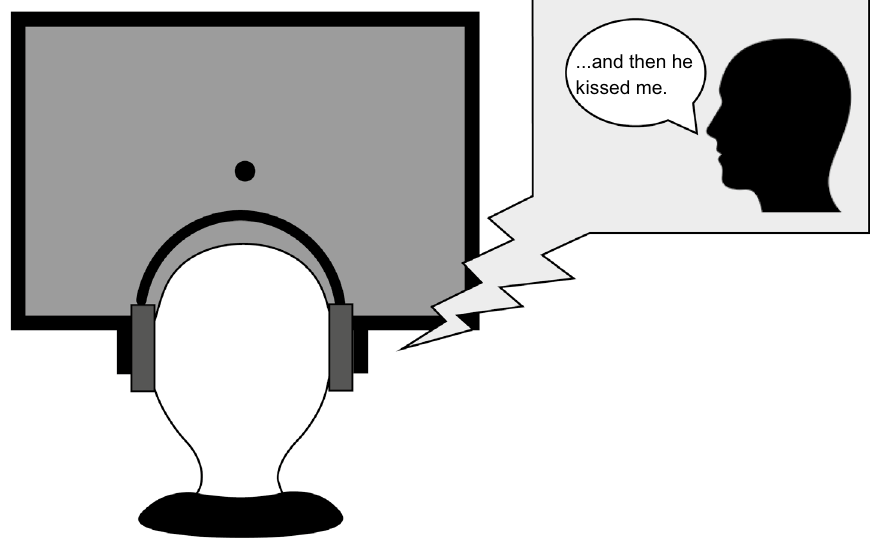
Figure 4. Illustration of the listening paradigm. Participants listened to speakers telling emotional stories while they fixated on a dot in the center of a computer screen. Both speakers’ and listeners’ eyes were tracked during this task. Figure created using Adobe Illustrator (Adobe Inc., 2020; Retrieved from https:// adobe. com/ produ cts/ illus